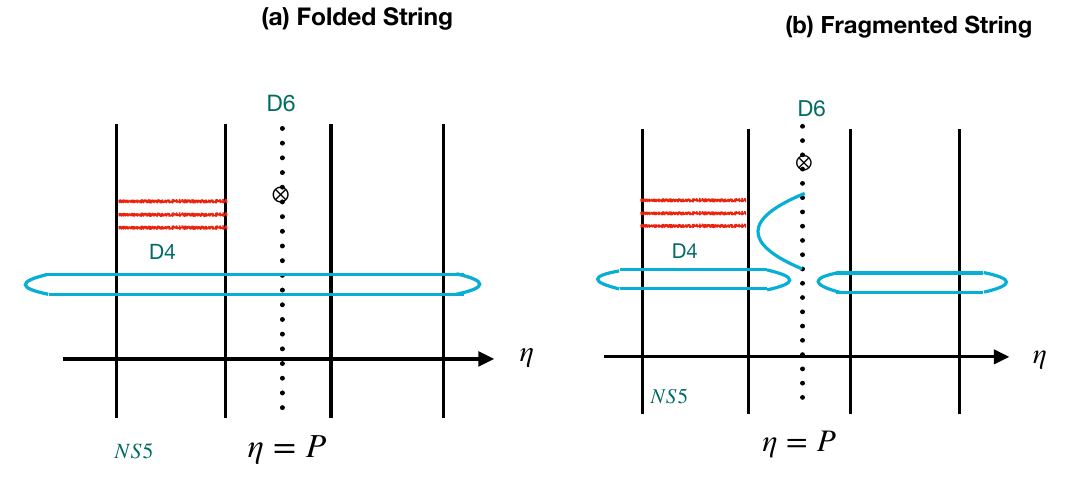
Figure 1 . We plot the rank ( r ) of the gauge group against the holographic direction ( d ) which in the dual string theory description is identified as one of the coordinates associated with the internal manifold. (a) Single kink profile corresponds to a quiver with linearly increasing rank that is closed by adding a SU(( m + 1) N ) flavour group at the end of the long chain. In the above figure this f correspods to placing flavour branes at d = d where m is a positive integer that increases by one, m (b) Uluru profile corresponds to associating flavour branes at two distinct points ( d and d ) m m + n along the nodes of the quiver and thereby changing the slope at d and d . m m + n